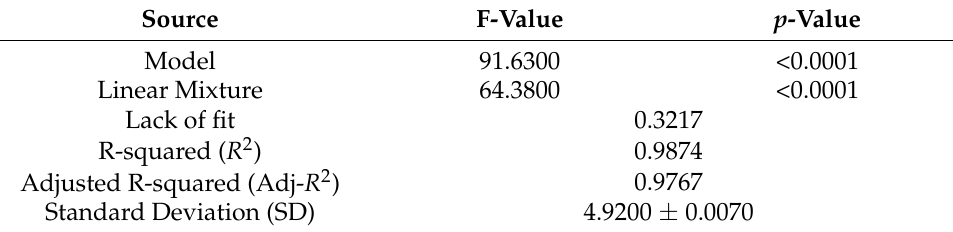
Table 4. Analysis of variance (ANOVA) for the model derived by the D-optimal mixture